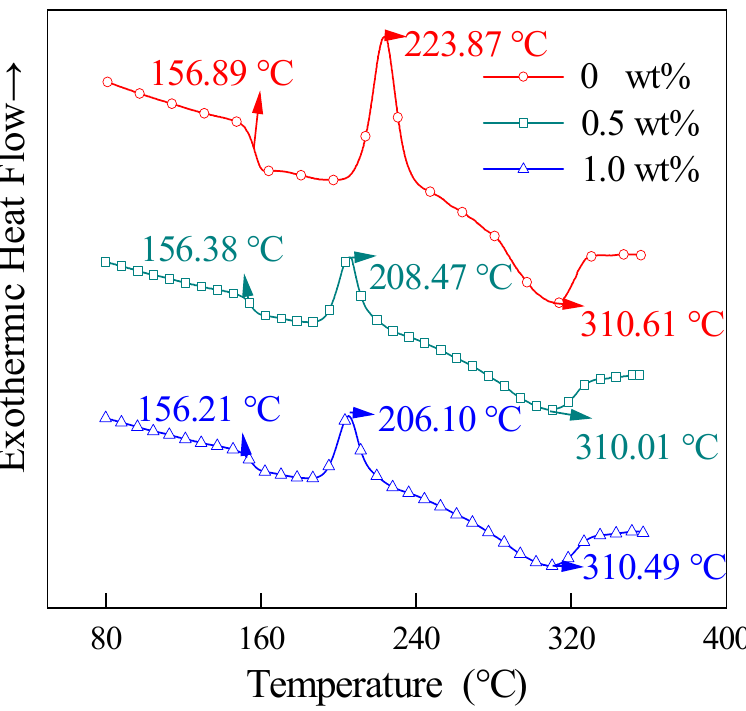
Figure 8. The DSC first heating curves of composites with different CNT contents.